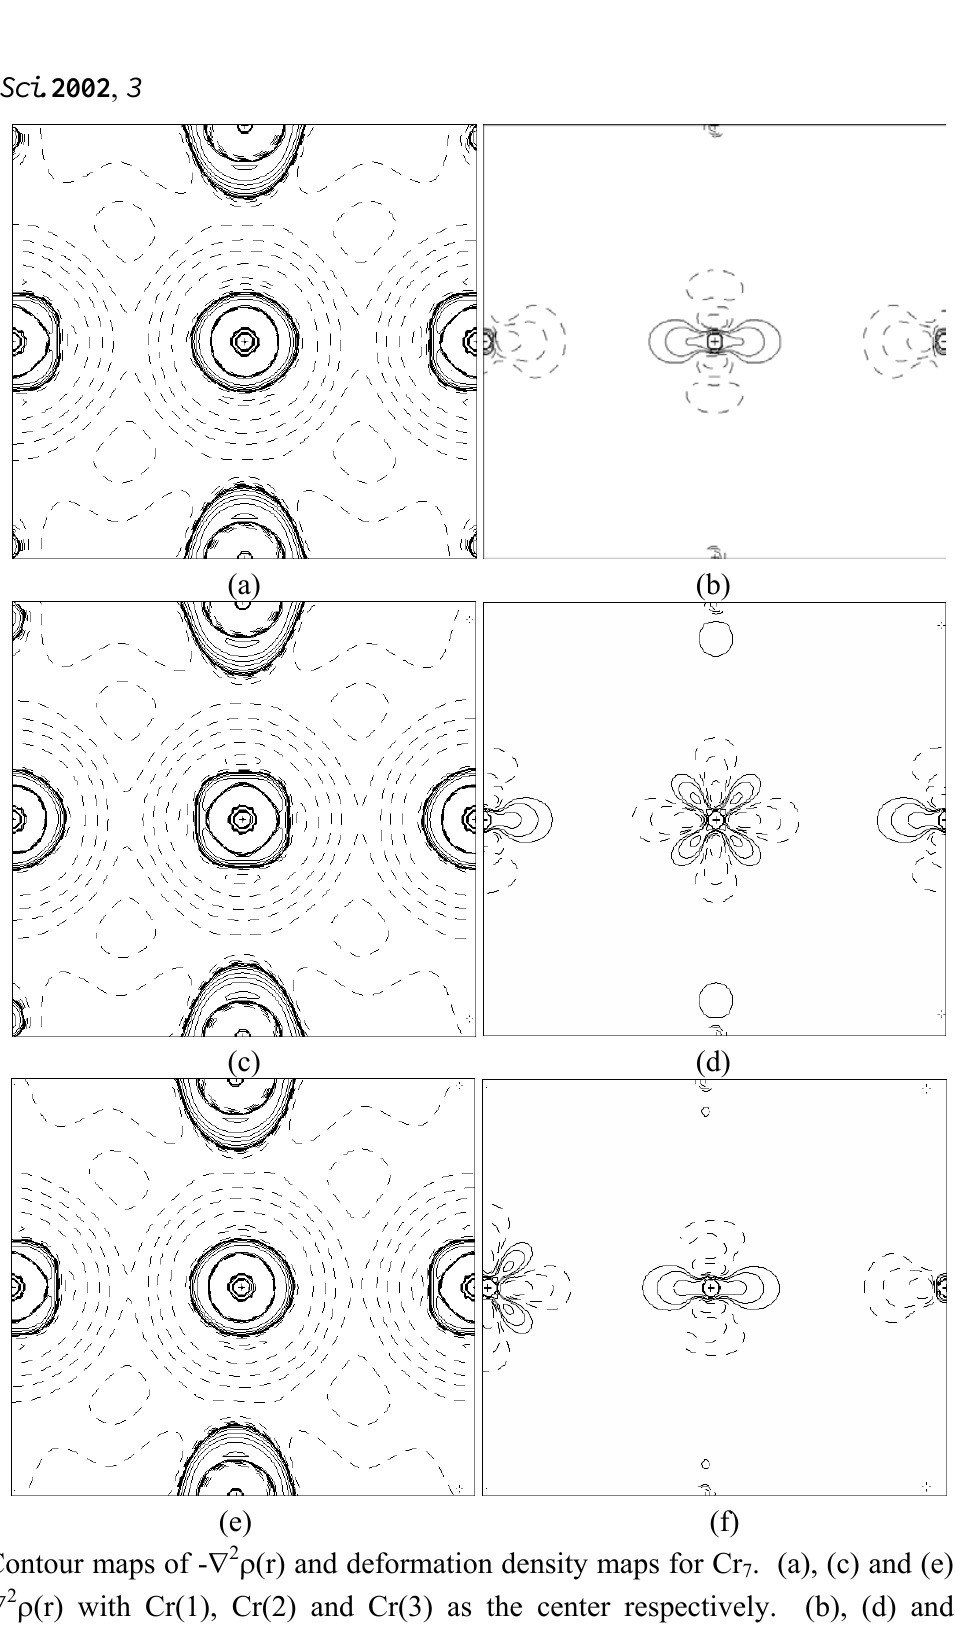
Figure 6 Contour maps of - ∇ 2 ρ (r) and deformation density maps for Cr maps of - ∇ 2 ρ (r) with Cr(1), Cr(2) and Cr(3) as the center respectively. (b), (d) and (f) are the corresponding deformation density maps. The rest are the same as those found in Figure